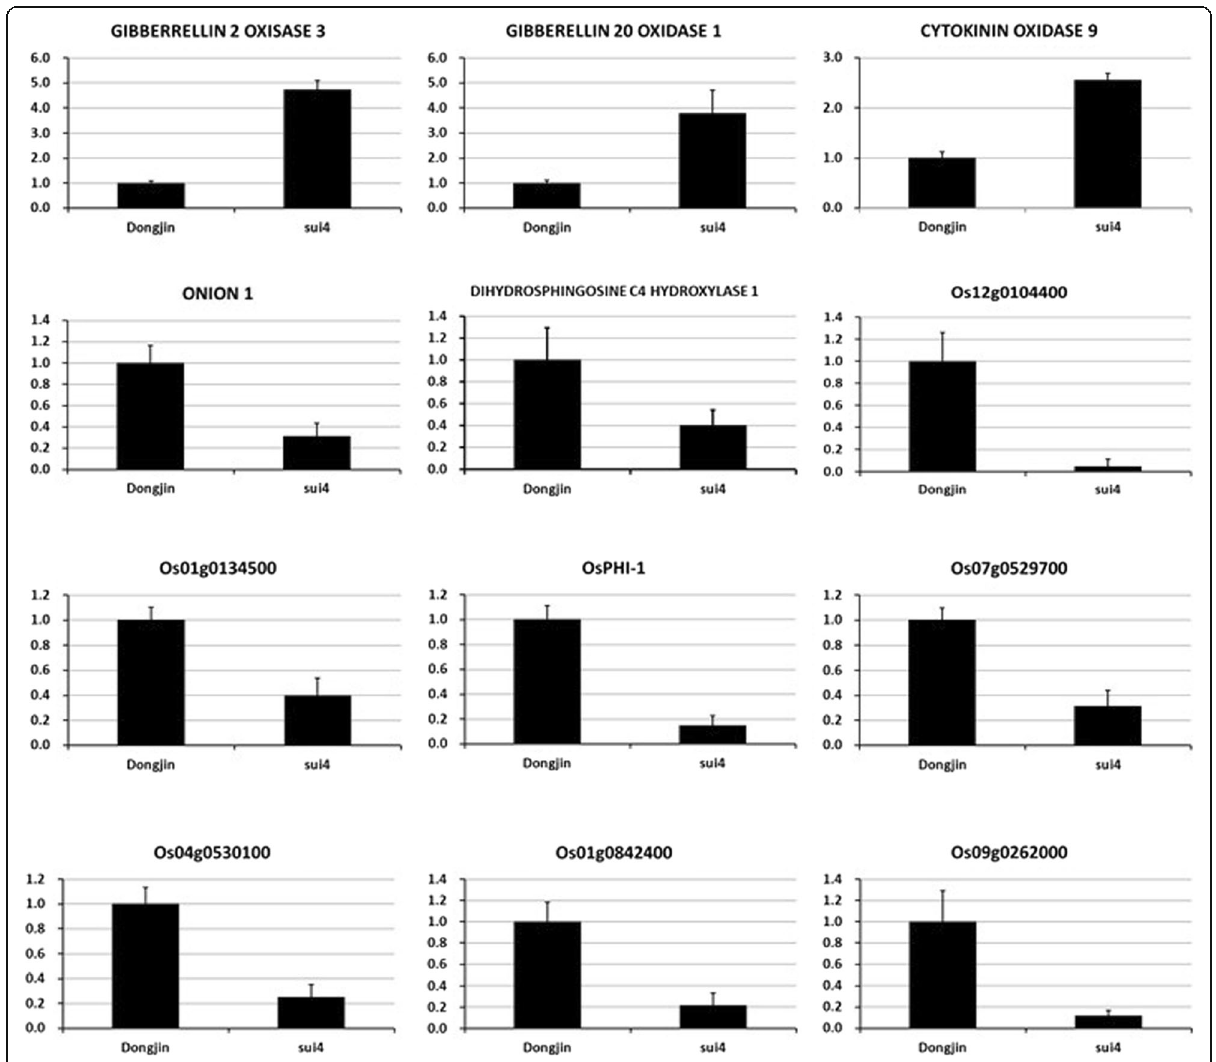
Fig. 6 Relative expression of representative DEGs in the culm of booting stage plants, as revealed by qRT-PCR. RNA was extracted from main culms of sui4 mutant and Dongjin palnts taken at the booting stage. The expression level in Dongjin plants was set as 1. Three biological replicates were performed. Error bars show SE ( n =